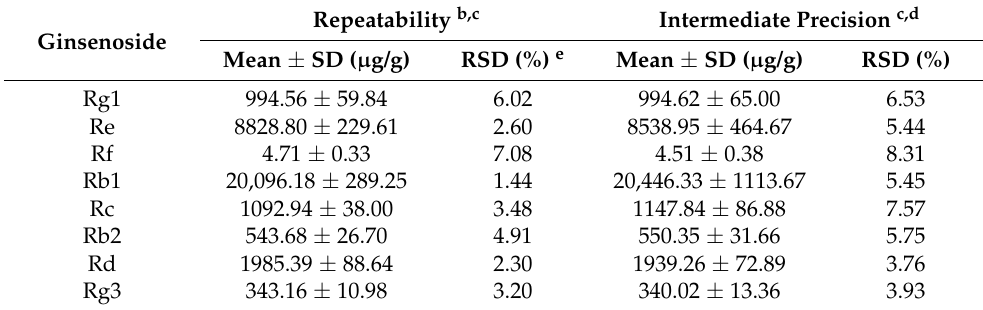
Table 8. Repeatability and intermediate precision of ginsenosides by UPLC-HRMS-MS/MS a .